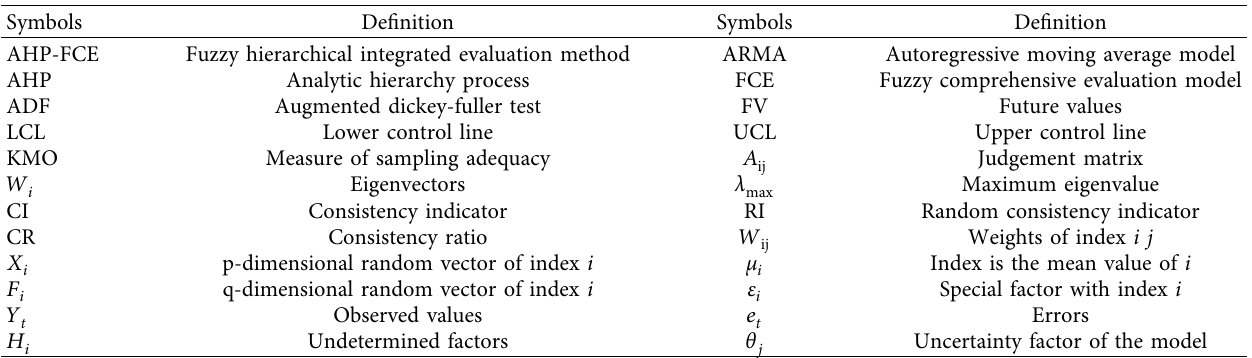
Table 1: Symbols.